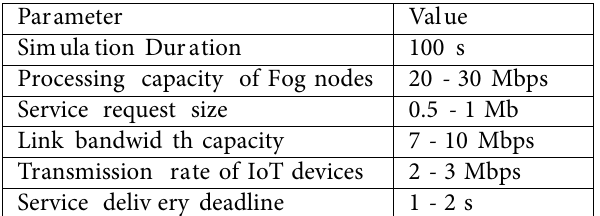
in to accoun t. As a resul t, a high amoun t of time is required for resource discov ery.